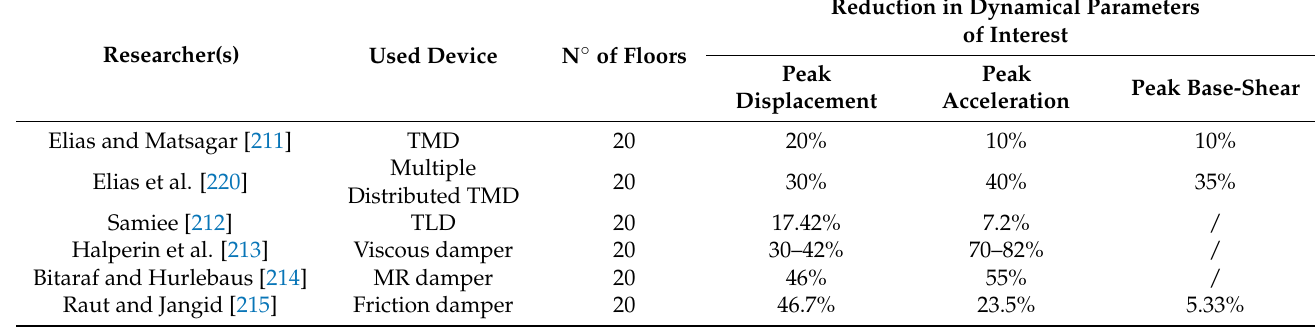
Table 1. Performance of various control strategies for reducing earthquake-induced vibrations in high-rise